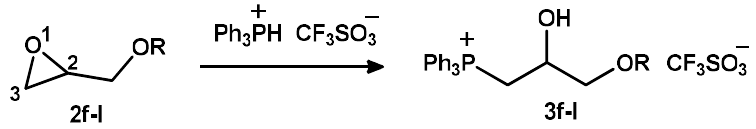
Figure 2. Geometry of independent part of crystal 3а . The hydroxyl group disorder is shown in molecule B. Anisotropic displacement ellipsoids are shown with a 50% probability. Hydrogen bonds are shown as dashed